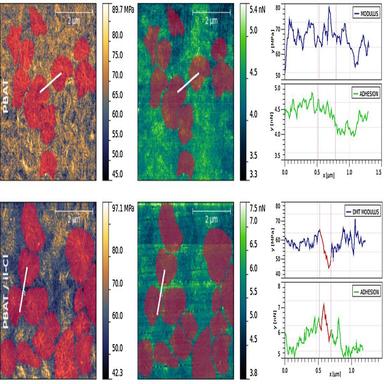
AFM 5 5 µm × 2 DMT modulus (left) and adhesion (center) images with corresponding profiles (right) for neat PBAT (top) and PBAT/il-Cl (bottom). The profiles are taken following the white lines in the images, and the vertical purple lines on the profiles correspond to the gaps between zones marked in red. Some (but not all) clearly identifiable spherulites are marked in red in the images. (For interpretation of the references to color in this figure legend, the reader is referred to the web version of this